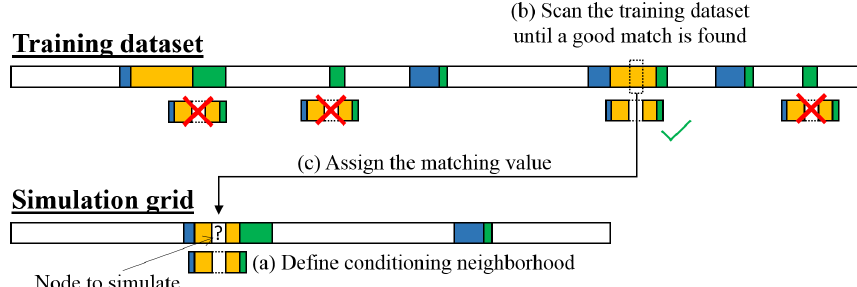
Figure 5. Schematic view of the MPS algorithm used for the nonparametric resampling of historical rain type time